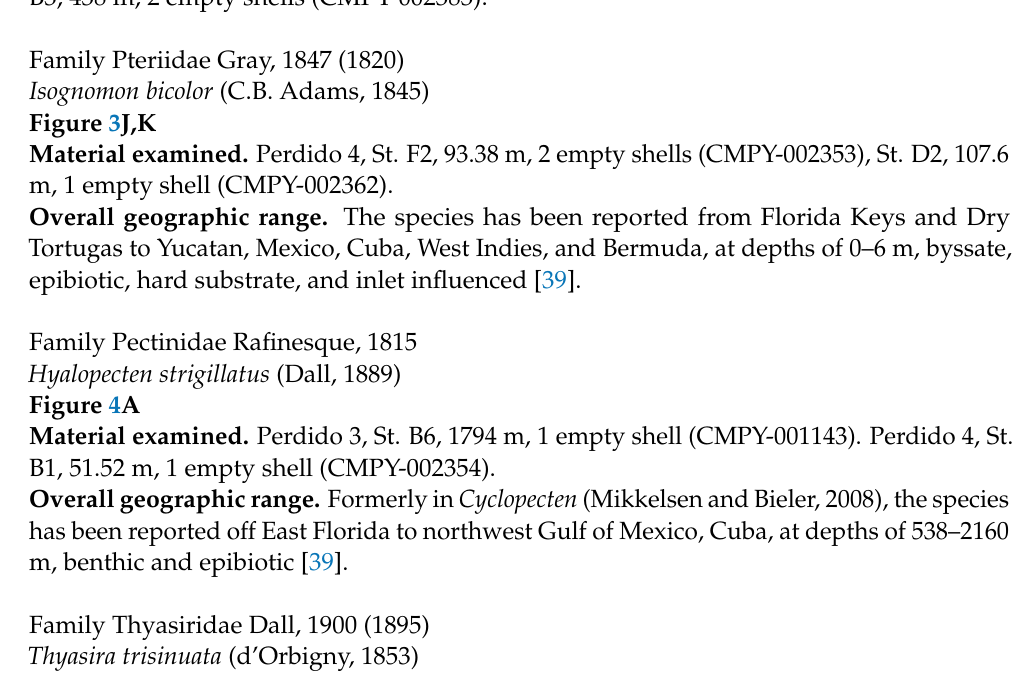
Material examined. Perdido 3, St. B3, 514 m, 1 empty shell (CMPY-001137). Overall geographic range. The species has been reported in Nova Scotia, Canada to north- west Gulf of Mexico, West Indies; Alaska to California, at depths of 14–680 m, benthic; infaunal and soft substrate (muds, sands, clays) [39]. Family Astartidae d’Orbigny, 1844 (1840) Astarte sp. Material examined. Perdido 3, St. C5, 1371 m, 2 empty shells (CMPY-001113), St. B6, 1794 m, 2 empty shells (CMPY-001127) and 2 empty shells (CMPY-001161), St. D5, 1244 m, 1 empty shell (CMPY-001196). Perdido 4, St. B5, 1543 m, 1 empty shell (CMPY-002448), St. Chapo, 1315 m, 2 empty shells (CMPY-002450), St. C5, 1267 m, 1 empty shell (CMPY- 002360), St. B1, 51.52 m, 2 empty shells (CMPY-002370), St. F4, 1378 m, 2 empty shells